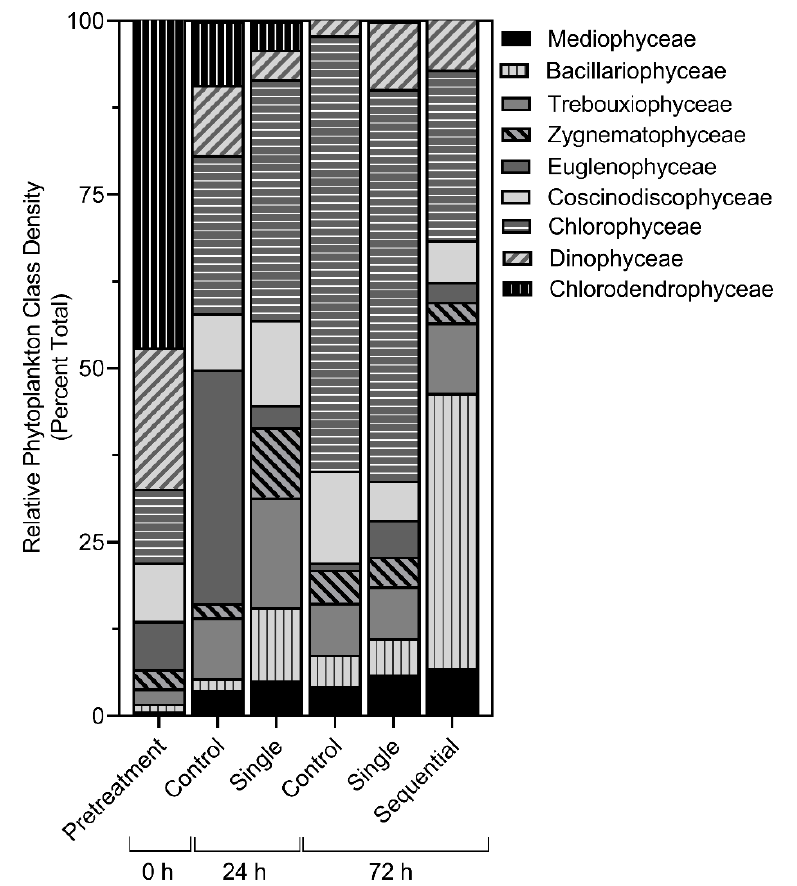
Figure 7. Phytoplankton community composition. Relative concentration per sample broken down by major class: Mediophyceae (black), Bacillariophyceae (light gray with black vertical stripes), Trebouxiophyceae (medium gray), Zygnematophyceae (medium gray with black angled stripes), Euglenophyceae (dark gray), Coscinodiscophyceae (light gray), Chlorophyceae (dark gray with white horizontal stripes), Dinophyceae (light gray with angled dark gray stripes), and Chlorodendrophyceae (black with white vertical stripes). Bars represent the average cell density for each genus ( n = 3).